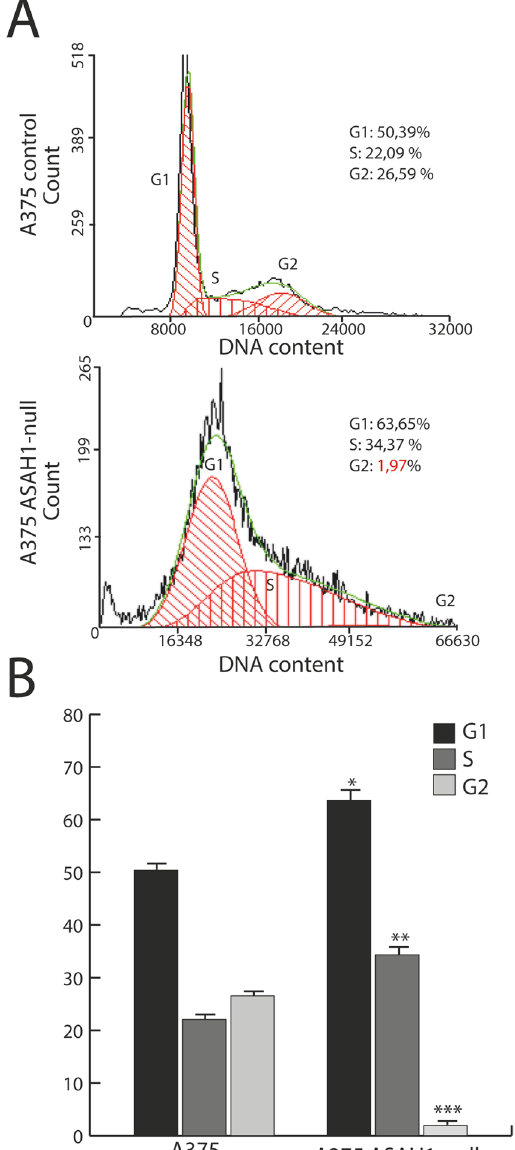
phases in control (scramble-treated, top) versus ASAH1 -null cells (bottom). ( B ) Statistical analysis of the cell cycle distribution was performed using the Student’s t test; * p < 0.05, ** p < 0,01, *** p < 0.001,. Experiments were performed 17 days after CRISPR/Cas9